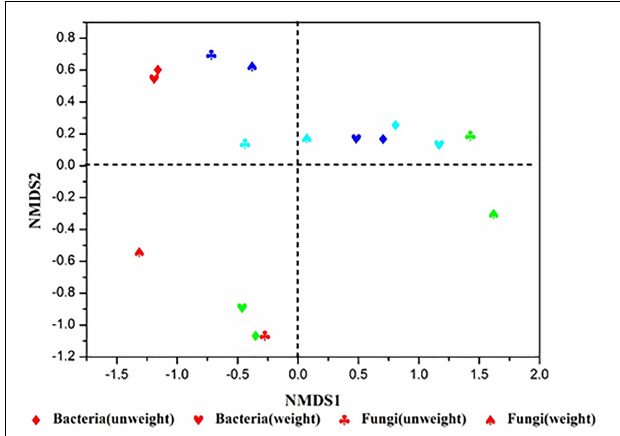
FIGURE 3 | Results of NMDS sequencing of Xiaoqu. No1, No2, No3, No4 are represented by red, green, sky blue, dark blue, respectively. The stress value of NMDS for microbial are all 0.0000.